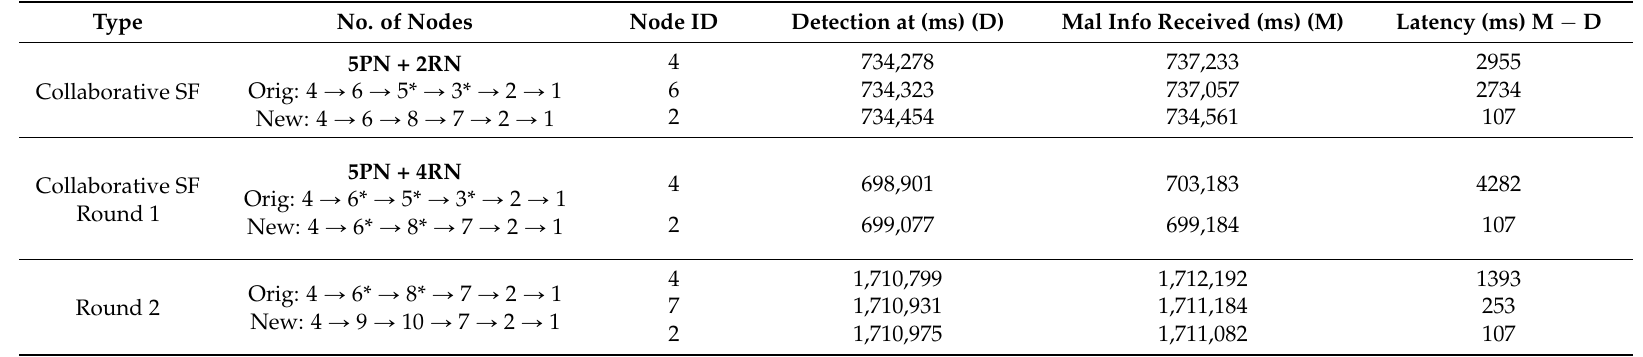
Table 4. Collaborative Selective